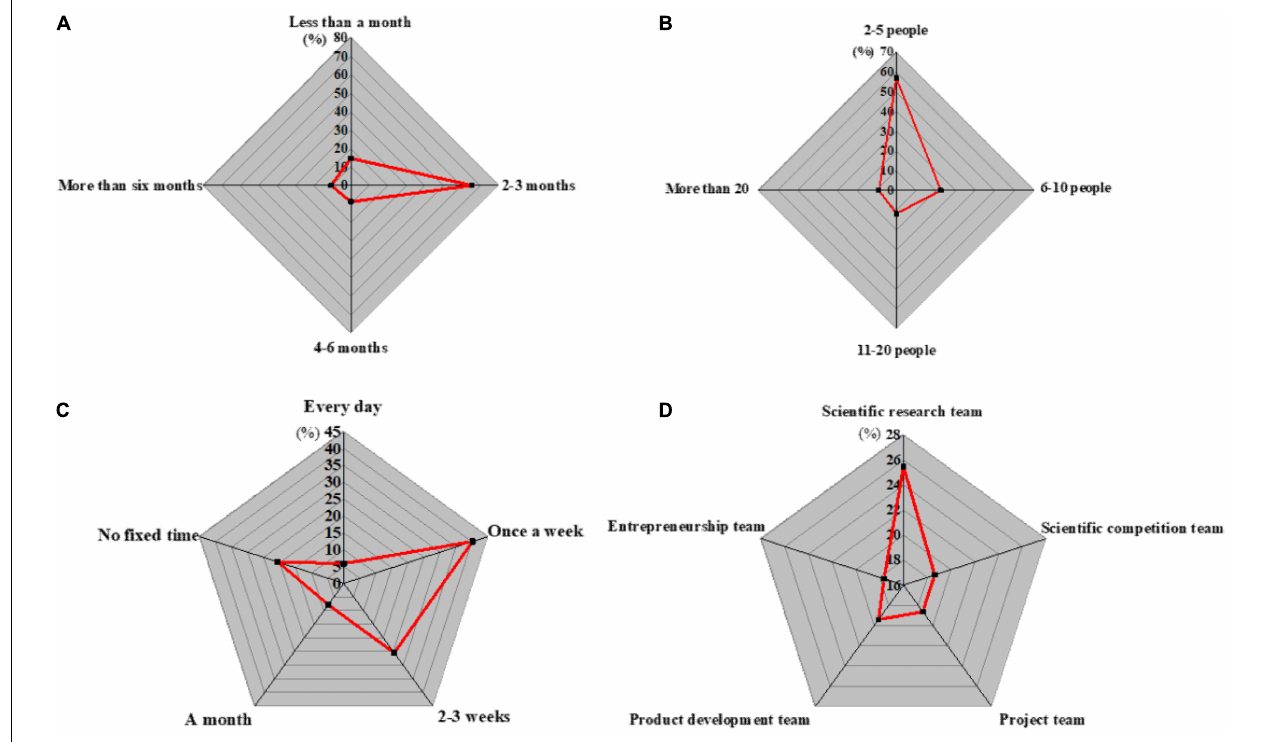
FIGURE 5 | Team level sample basic information. (A) Team establishment time; (B) Team size; (C) Team communication; (D) Team